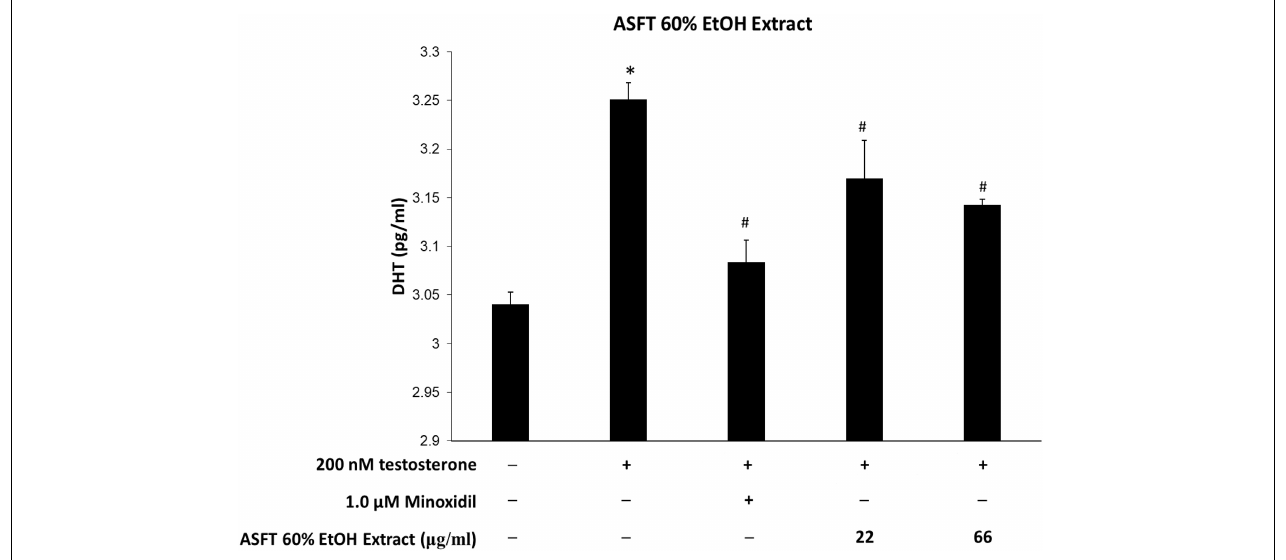
FIGURE 10 | Inhibitory effect of 60% ethanol extract from Alnus sibirica Fisch. ex Turcz (ASFT) on dihydrotestosterone (DHT) formation. Cells were pre-incubated with the indicated dose of 60% ethanol extract from ASFT and treated with testosterone. The DHT content (pg/ml) in the cell lysates was measured as described in the manufacturer’s instruction. Data were expressed as mean ± SD. * P < 0.05 vs normal group. # P < 0.05 vs testosterone-treated group. +, present; –,